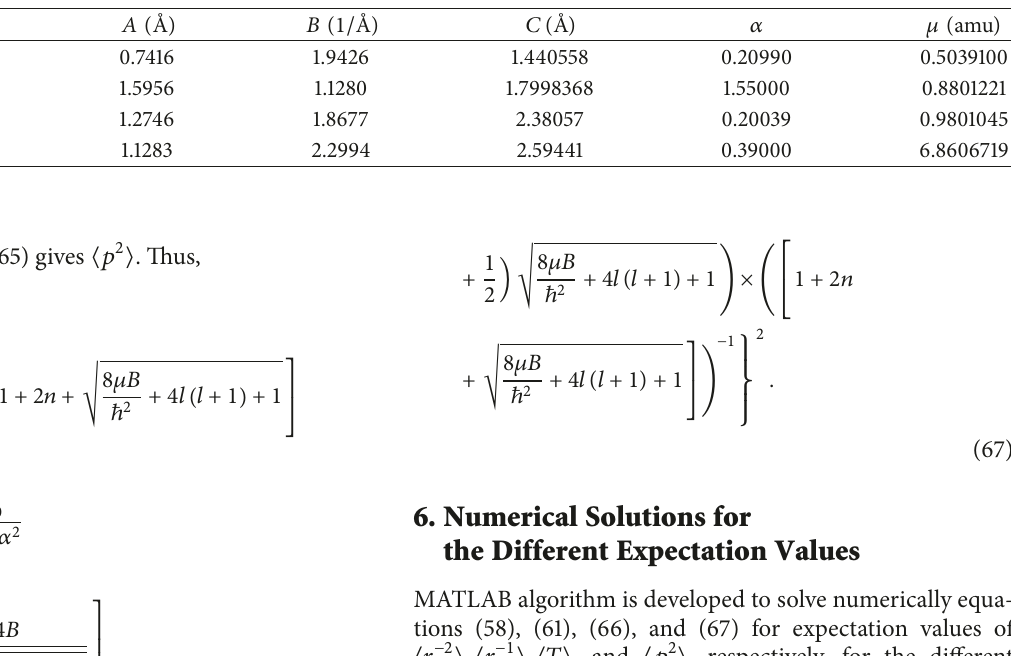
Table 1: Molecular parameter using Nikiforov-Uvarov